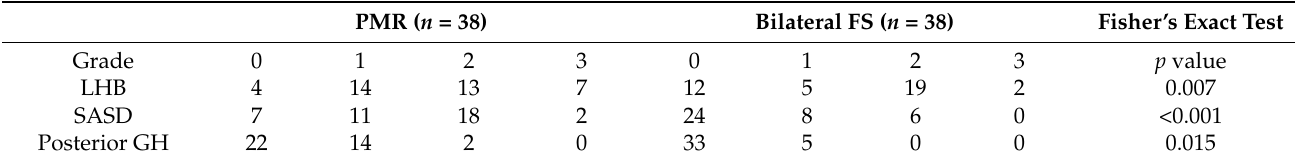
Table 4. Distributions of power Doppler grades for three different sites around the shoulder joints in patients with PMR and bilateral